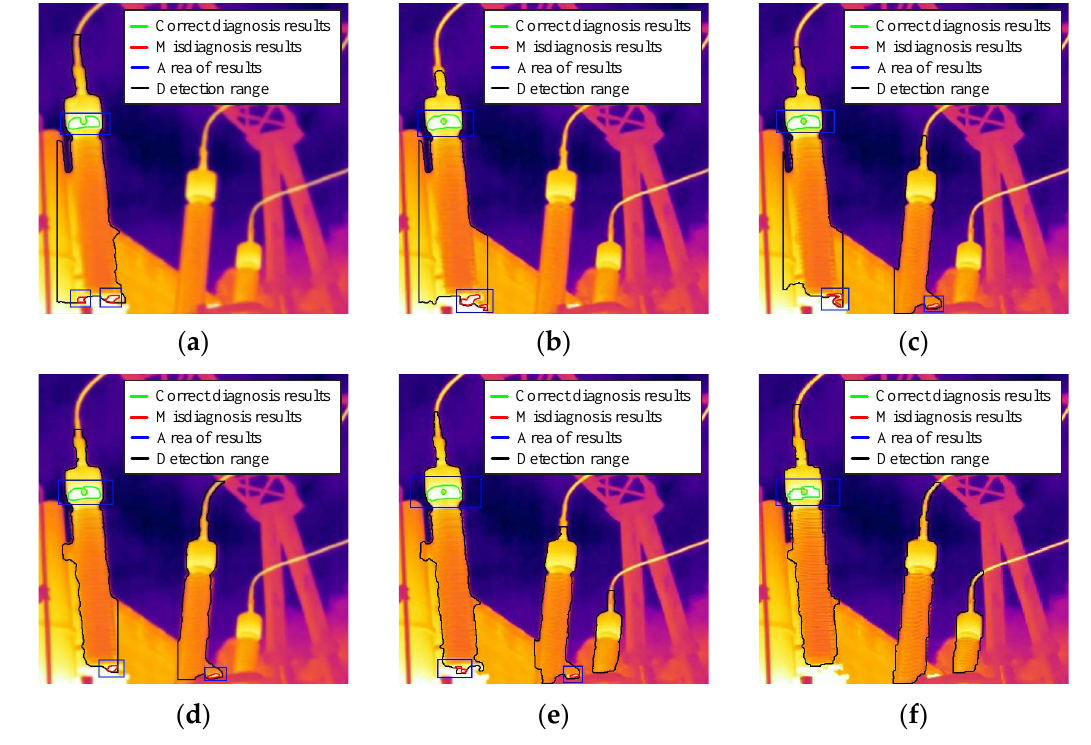
Figure 13. Final diagnosis results of reconstructed images by different methods ( a ) LR ( b ) Keys’ ( c )